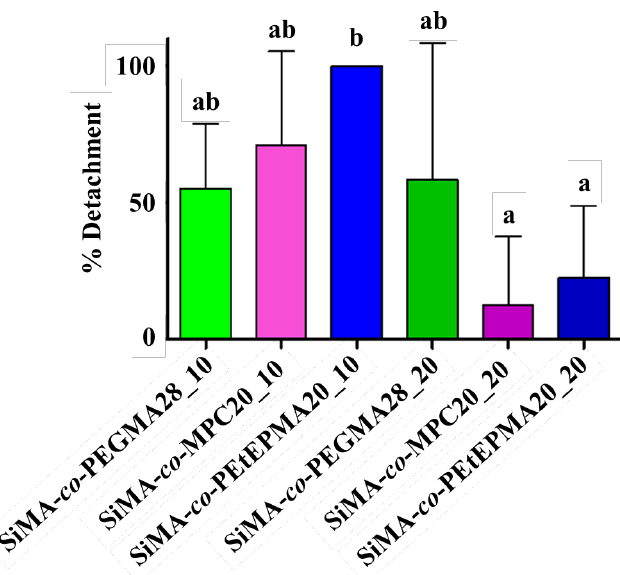
Figure 6. Percentage of detachment of F. enigmaticus adults from different surface samples, after 25 Pa shear stress exposure (15 min). An ANOVA analysis (n = 3) followed by a Tukey post-hoc test were performed for multiple comparisons. Not-shared letters indicate statistically significant differences, p ≤ 0.05. Detachment percentage for PDMS was 70.84 ± 20.97% (mean ± standard deviation).